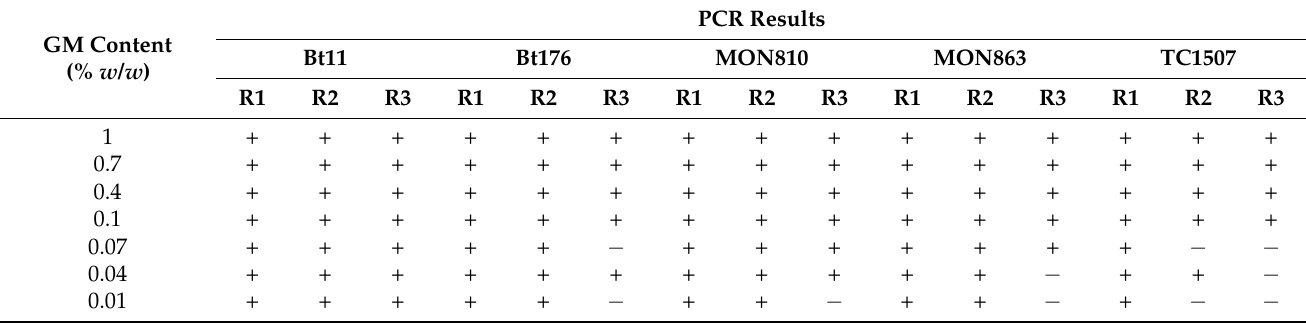
Table 1. Results of limit-of-detection